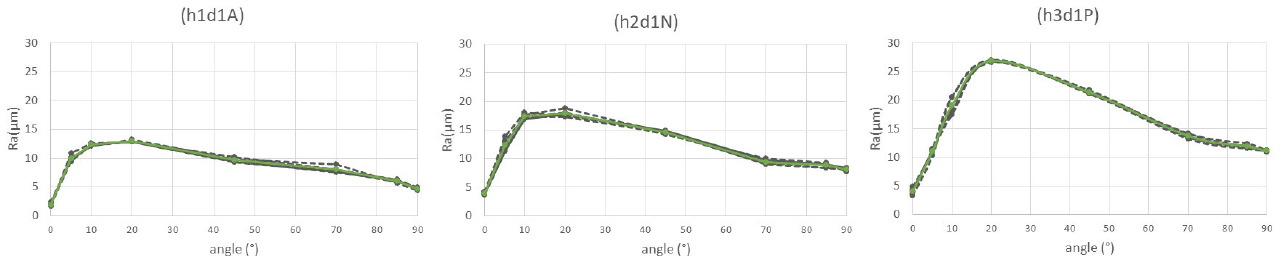
Figure 4. Ra average (green line) in h1d1ABS, h2d1 nylon and h3d1PLA.